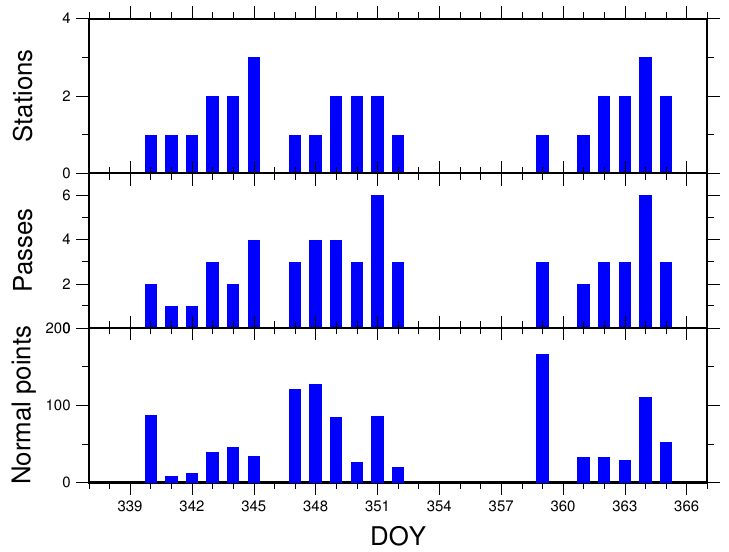
(cid:3) Figure 10. Statistics of the SLR observation data from 3–31 December 2016.